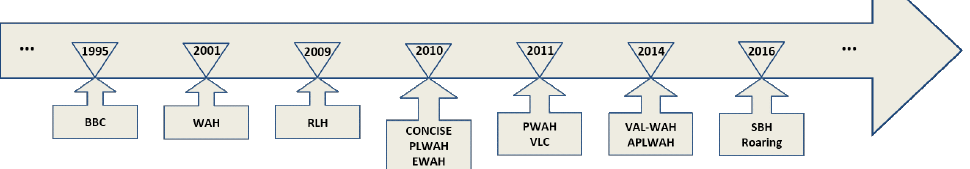
Figure 2. A brief history of compression